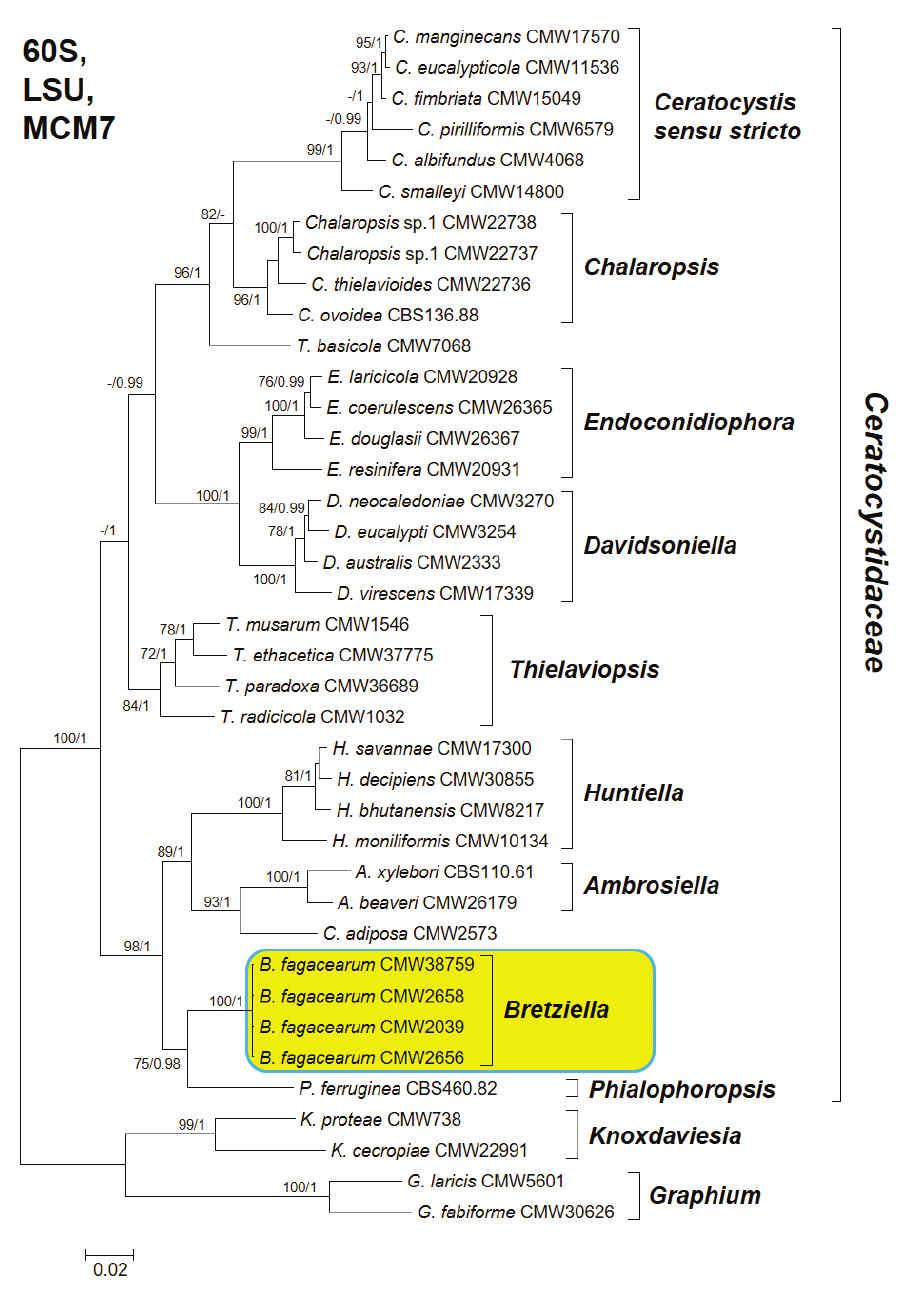
Figure 1. Bayesian phylogram derived from the analyses of the concatenated dataset (60S, LSU, MCM7). Maximum likelihood bootstrap values (≥ 70 %, 1000 replicates) and Bayesian posterior probabilities val- ues (≥ 0.95) are indicated at nodes. “-” indicated no phylogenetic support or the support values are below 70% for ML and 0.95 for